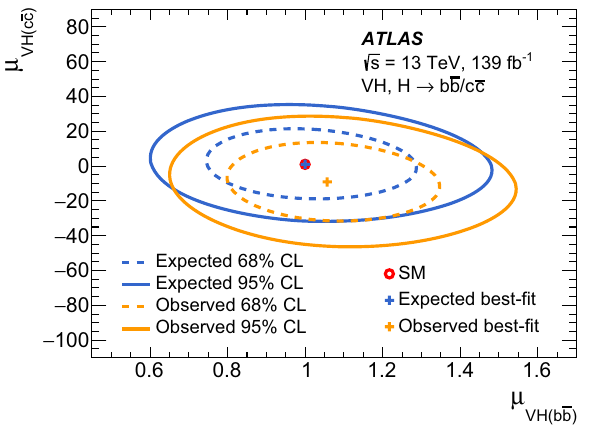
Fig. 5 The observed and expected best fit values of μ VH ( c ¯ c ) and μ with their 68% and 95% CL contours VH ( b ¯ b )